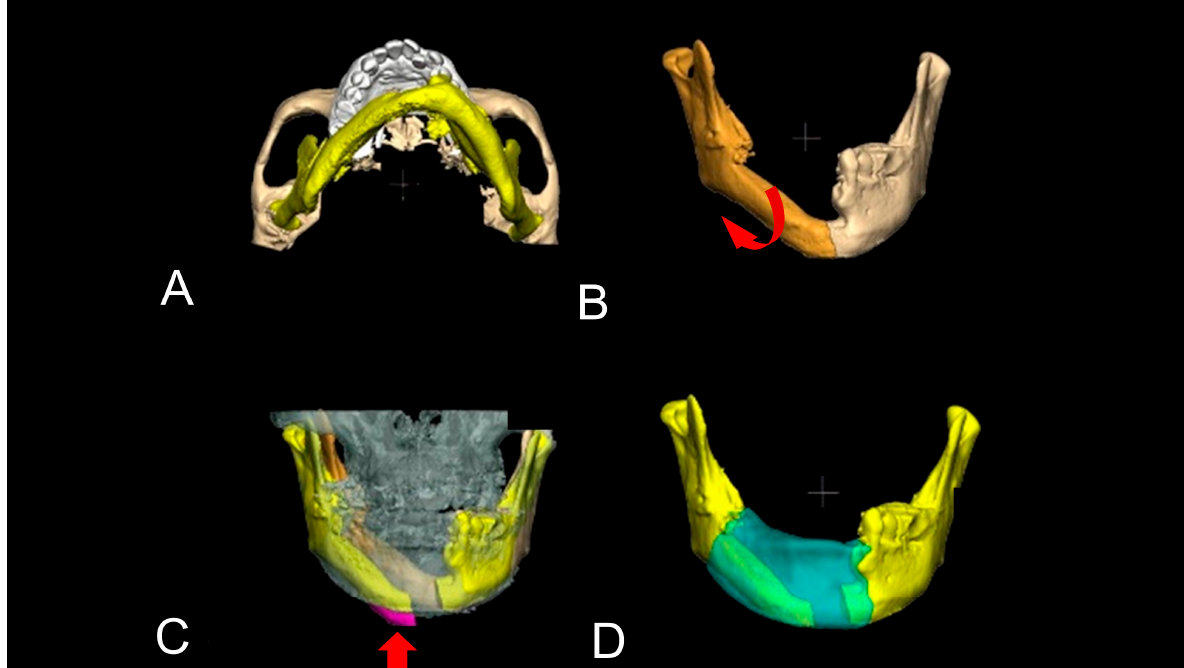
Figure 6. Complicated mandibular deviation with shortened and malpositioned bone graft. This is a case of segmental mandibular defect due to a tumour resection with radical neck dissection (Case 11). The mandible was reconstructed with a fibular free flap simultaneously. The yellow mandible indicates a deviated reconstructed mandible. The patient’s facial appearance was good; however, his alveolar bone for dental rehabilitation was poor ( A ). The dark brown mandible is detached at the midline and moved outwards to correct the deviation. The red arrow indicates the direction in which the detached mandible should be returned to its normal position ( B ). Preoperative CT suggested that the bilateral condyles were displaced and the length of the reconstructed mandible was unnatural ( C ). This condition made the mandible deviate to the left side and dental occlusion was poor with the remaining teeth. Thus, the first step of virtual mandibular reconstruction was to cut the reconstructed mandible ( C ). The second step was the adjustment of the displaced condylar position. Additionally, the third step was the superimposition of the remaining teeth. After these processes, the pink area of protruding bone was cut (red arrow), and the exact mandibular morphology was reconstructed virtually and green indicates the bone graft ( D